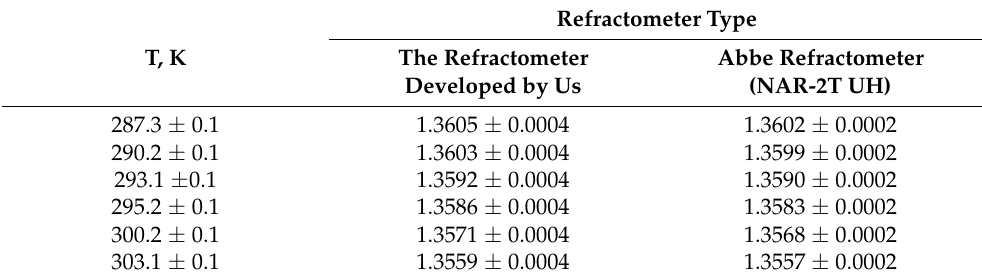
Table 2. The change in the refractive index n m of engine oil “Rheinol PRIMUS PX 5W-40” from temperature